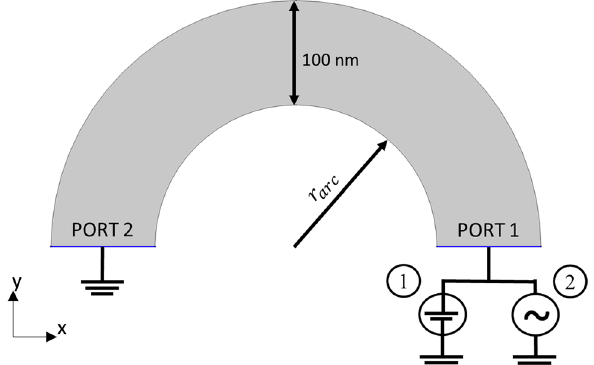
Figure 1. Schematic setup of the graphene arcs. In the dipole model, all of the arc’s charges are concentrated at a single point and traverse a semicircular trajectory at a radius r arc . The motion of the charges is expected to produce cyclotron radiation at frequencies inversely proportional to r arc . For the finite element DC simulation (1), a constant 1 V was applied. For the finite element RF simulation (2), signals at 4 GHz, 10 GHz, and 40 GHz of 1 V amplitude were applied to port